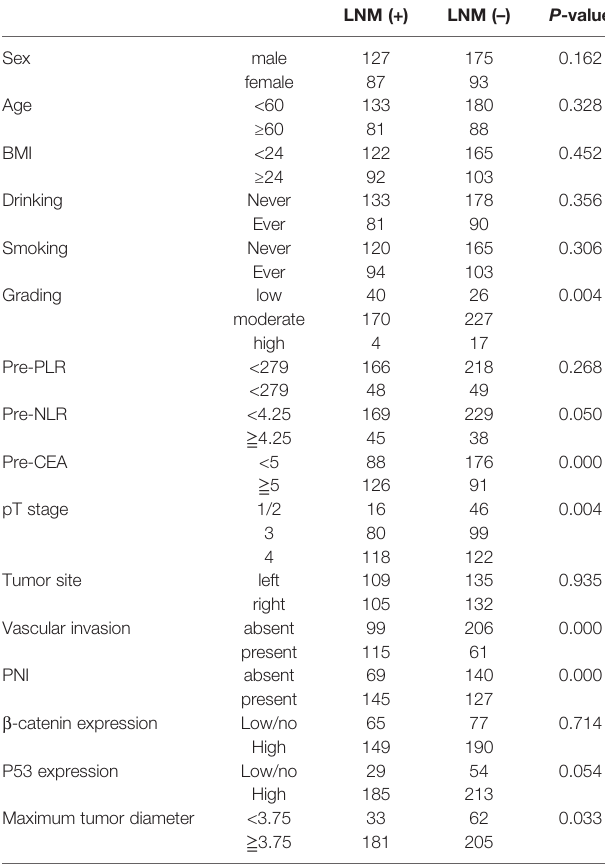
BMI, Body mass index; CEA, Carcinoembryonic antigen; PLR, Platelet/lymphocyte; NLR, Neutrophil/lymphocyte; p-T, pathological Tumor Stage; PNI, Peripheral nerve in fi ltration; LNM, Lymph Node